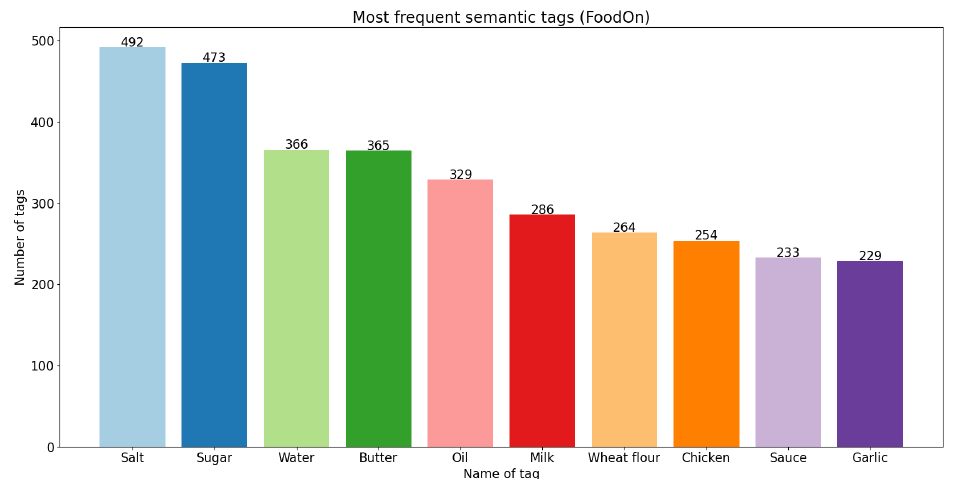
Figure 6. Ten most frequent semantic tags from